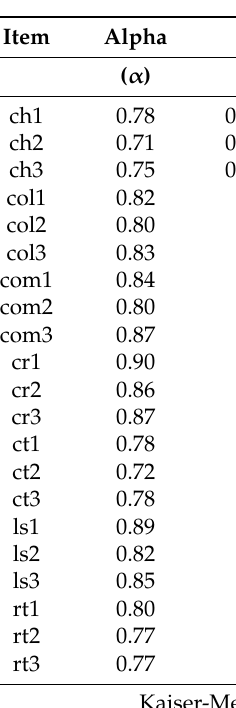
Table 1. Rotated Component Matrix with KMO & Bartlett’s Test and Cronbach’s Alpha ( α